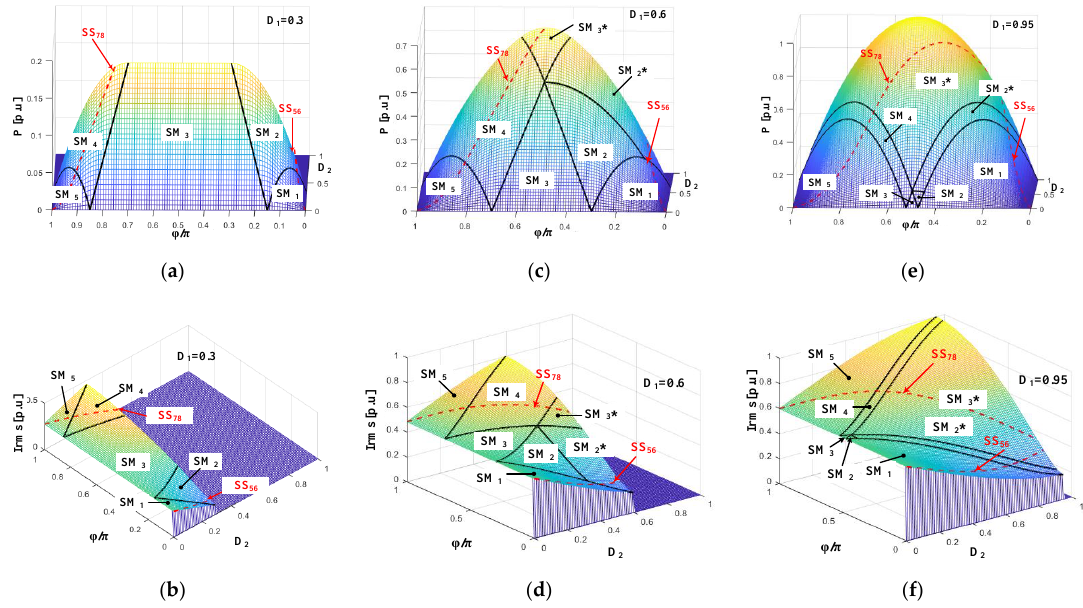
Figure 8. Case I: Power and RMS current per unit [p.u] normalized to the maximum values, and switching modes for different D 1 values when d = 0.677. ( a ) Power for D 1 = 0.3; ( b ) RMS current for D 1 = 0.3; ( c ) Power for D 1 = 0.6; ( d ) RMS current for D 1 = 0.6; ( e ) Power for D 1 = 0.95; and ( f ) RMS current for D 1 = 0.95.